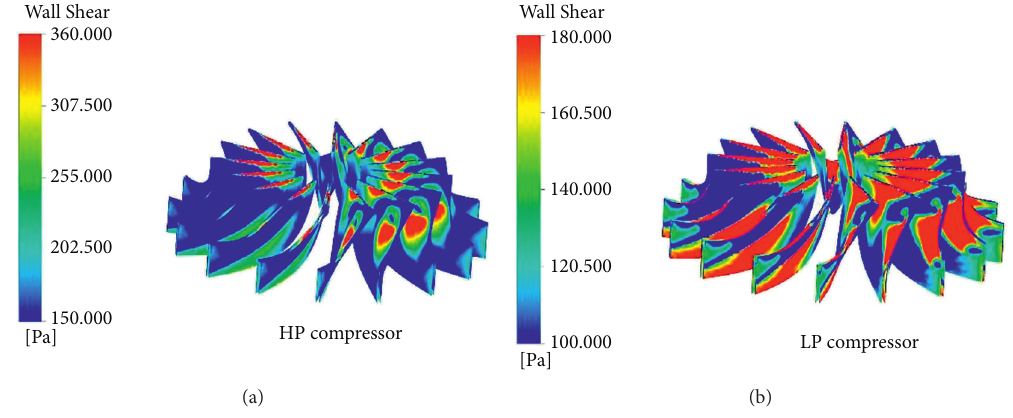
Figure 12: Contour of shear stress for (a) HP Compressor (b) LP Compressor.